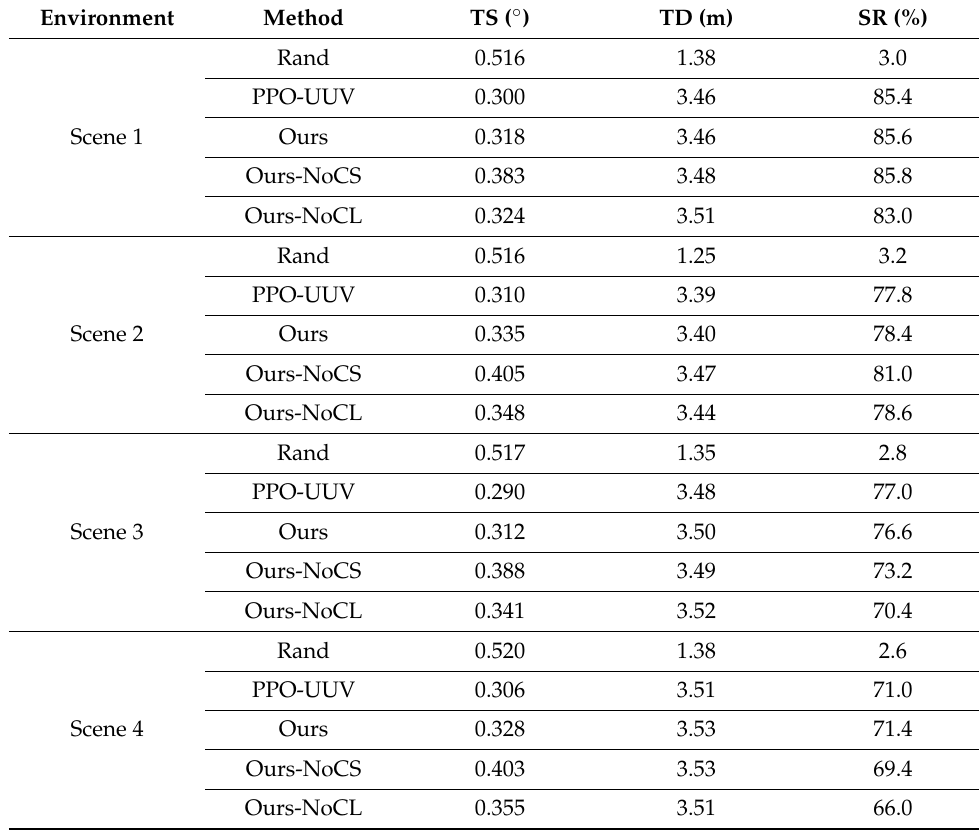
Table 2. Evaluation of the different methods in test scenarios.